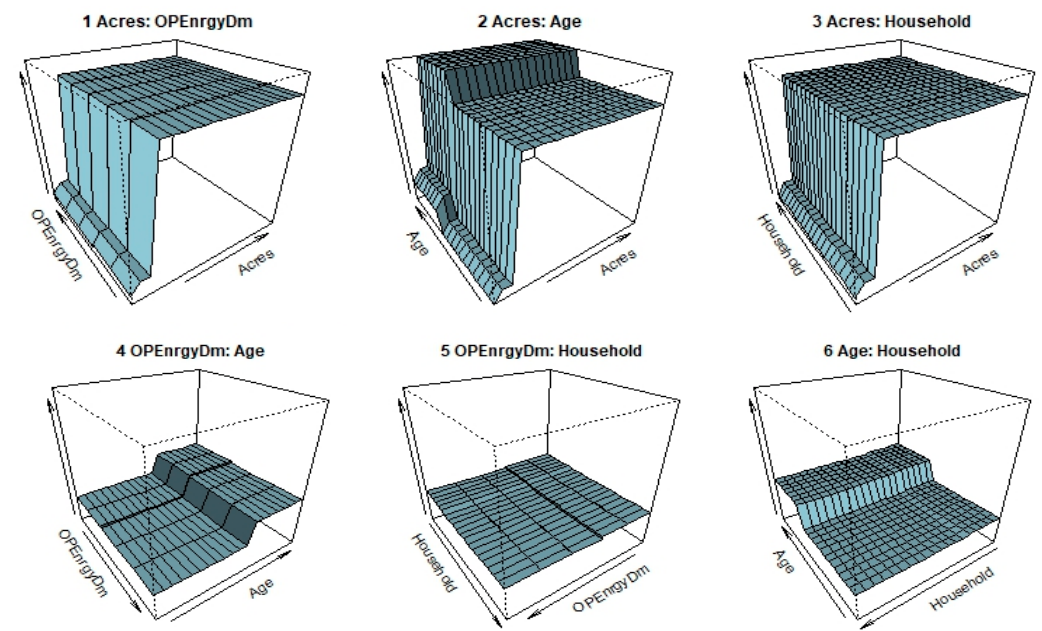
Figure 11. Interaction of variables for acres commitment model to rent.